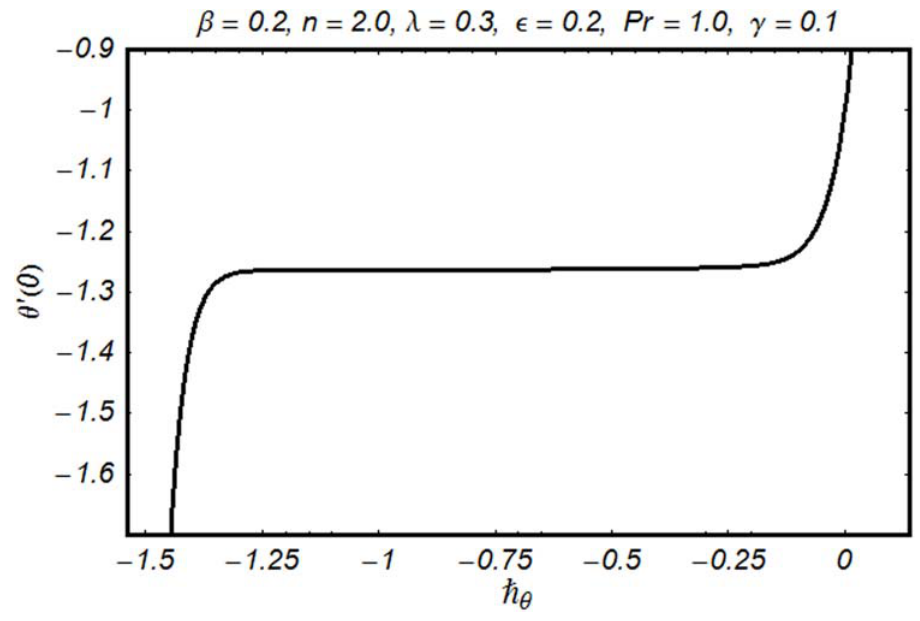
Fig 3. ℏ -curve for θ .